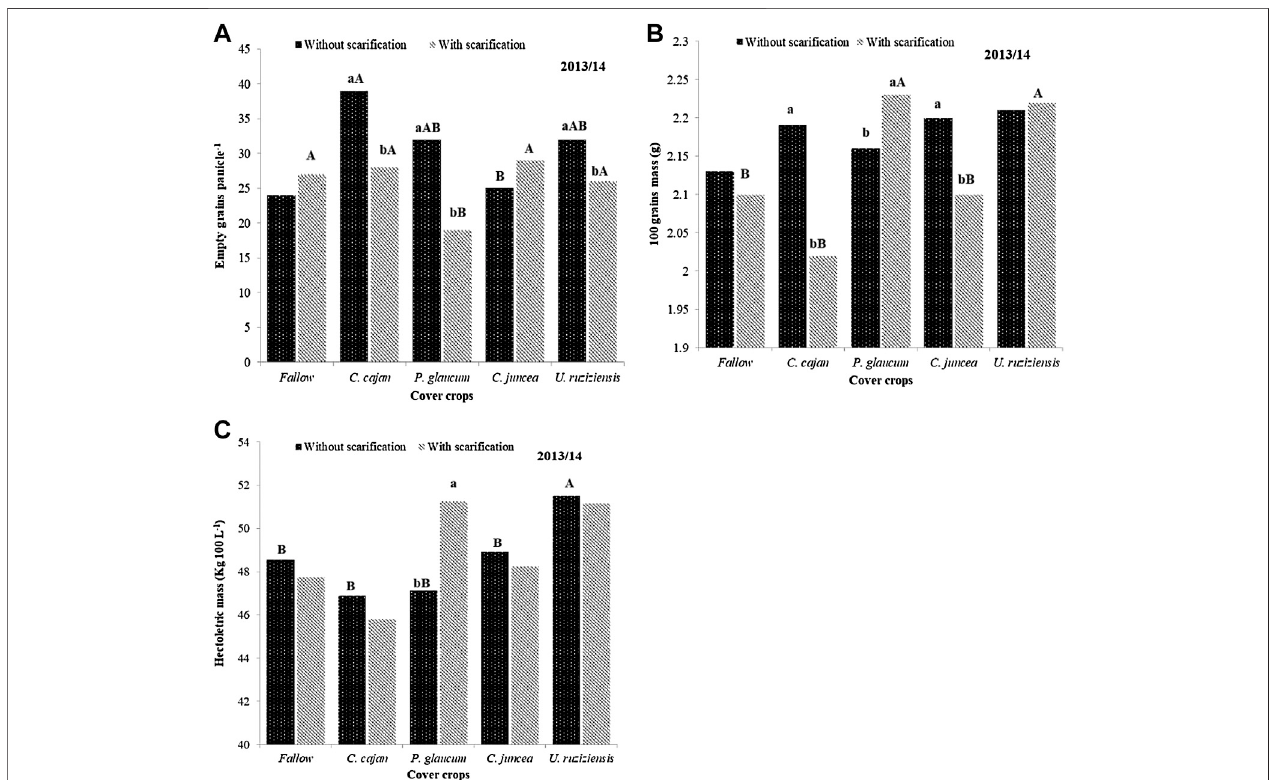
FIGURE 3 | Effect of mechanical soil scari fi cation and cover crops in the no-tillage system on tnumber of empty grains panicle − 1 (A) , 100-grain weight (B) , and hectoliter mass (C) of upland rice in 2013/2014 cropping season. Means followed by same lowercase letter for CC within MS and uppercase for MS within CC were statistically not different by Tukey test at 5%